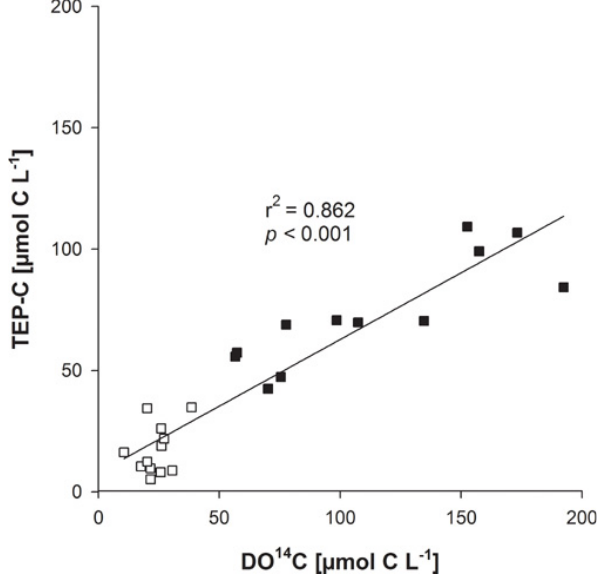
Fig. 4. Concentrations of the carbon content of transparent exopolymer particles (TEP-C) at various growth-, CO 2 and temper- ature conditions. Mean values and standard deviations were derived from sampling 1, 2 and 3 ( µ = 0 . 3d − 1 ) and sampling 4, 5 and 6 ( µ = 0 . 1d − 1 ) , respectively.